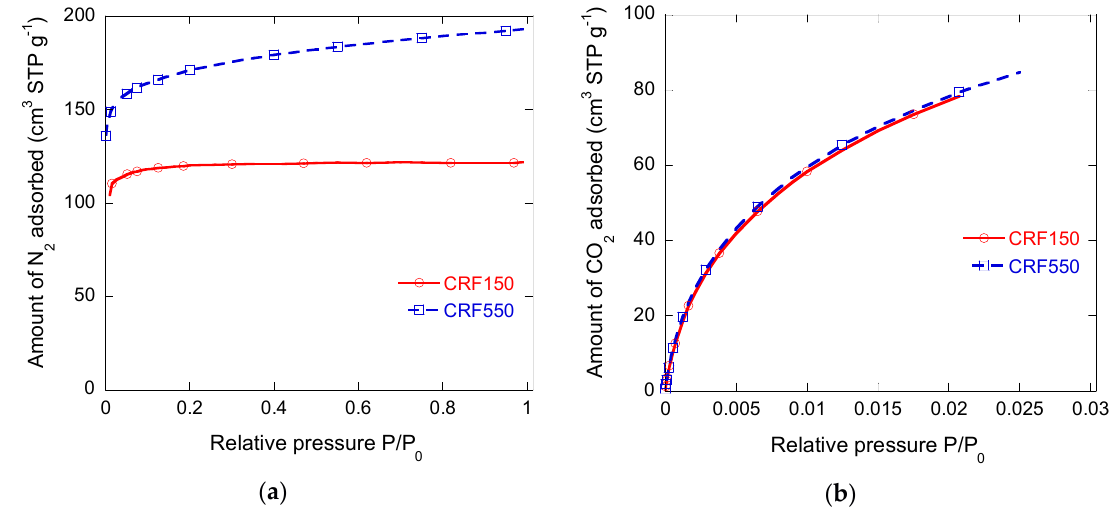
Figure 4. Adsorption isotherms measured for CRF150 and CRF550 samples: ( a ) N 2 at − 196 °C; ( b ) CO 2 at 0 °C.